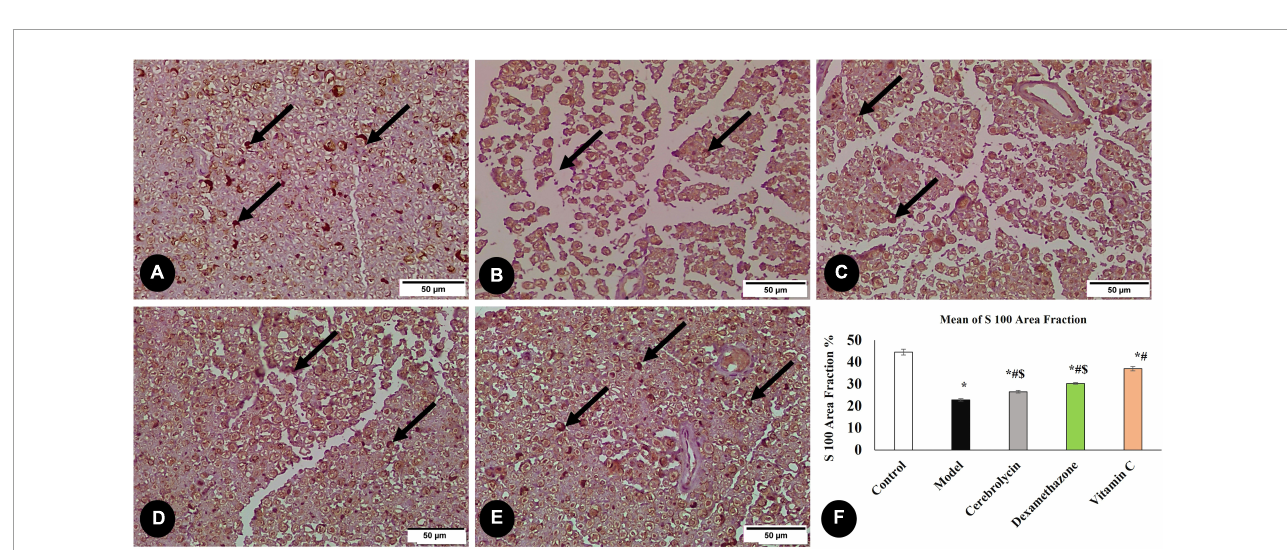
FIGURE6 Immunohistochemical analysis of S100 marker in the control group (A) , the model group (B) , the Cerebrolysin group (C) , the dexamethasone group (D) , and vitamin C (E) . Arrows point to positively stained cells. (F) Comparison of the expression between different groups. S100 expression was significantly decreased in the model group as compared to the control group. The Cerebrolysin group, dexamethasone group, and vitamin C cause a significant increase in S100 expression correlated with the model group. There was no significant difference between Cerebrolysin and dexamethasone. *Significance as compared to control, # significance as compared to the model, and $ significance as compared to Vit C